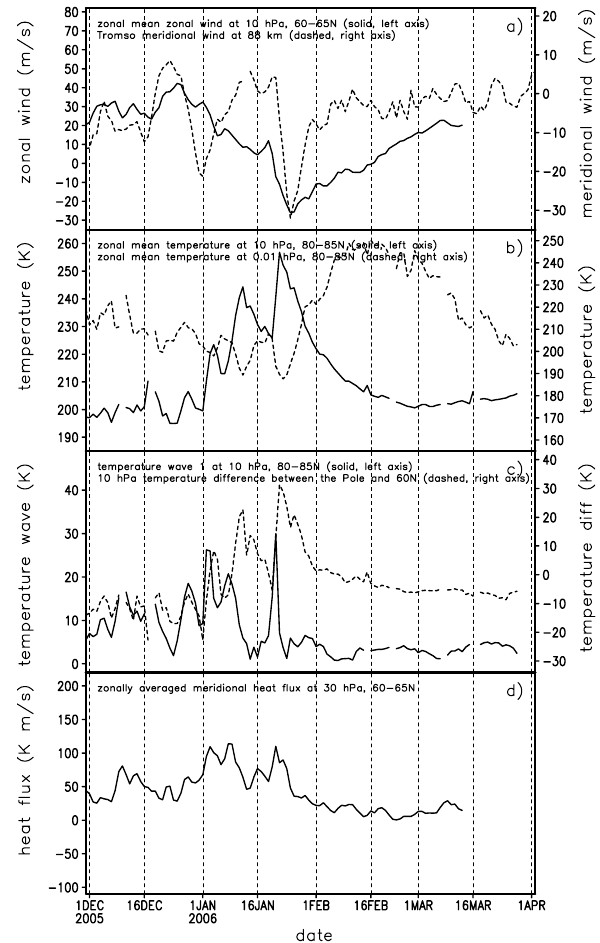
Fig. 2. As in Fig. 1, but for the 2005/2006 winter and the meridional wind in panel (a) comes from Tromsø (70 ◦ N, 19 ◦ E) MF radar ob-